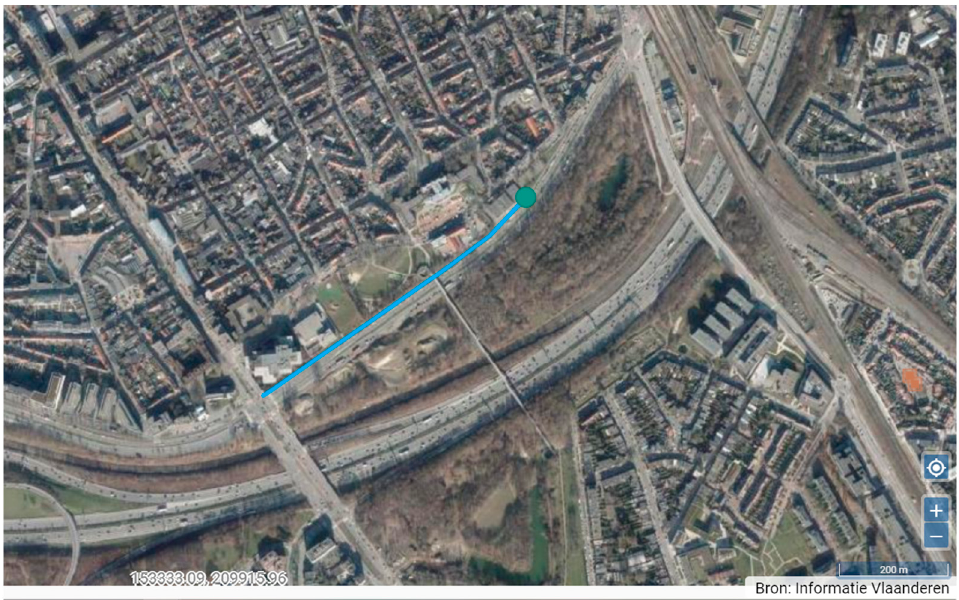
Figure A2. Overview of the catchment in Wilsele. The green dot shows the inspection well where the samples were taken. The blue area is connected to the inspection well.